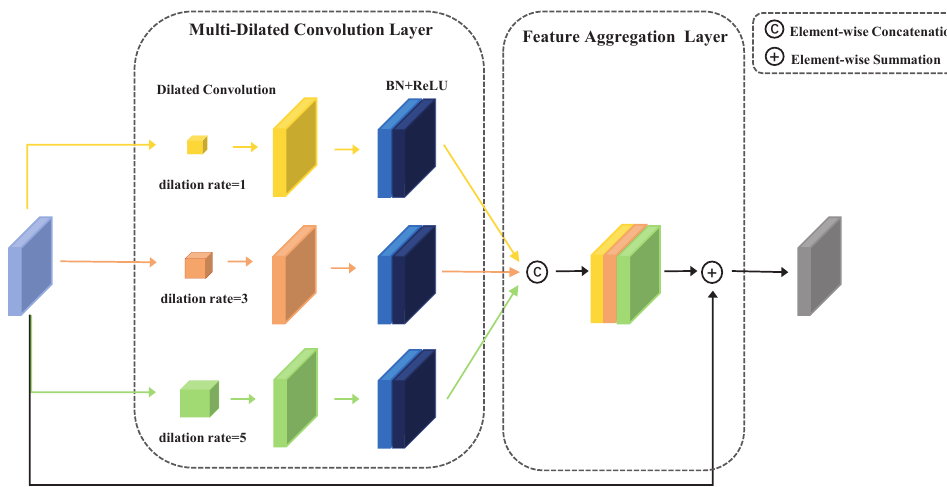
Figure 2. The architecture of the efficient feature-extraction module (EFM). The multi-dilated convo- lution layer has three different dilation rates: 1, 3, and 5. The feature aggregation layer contains two operations: element-wise concatenation and element-wise